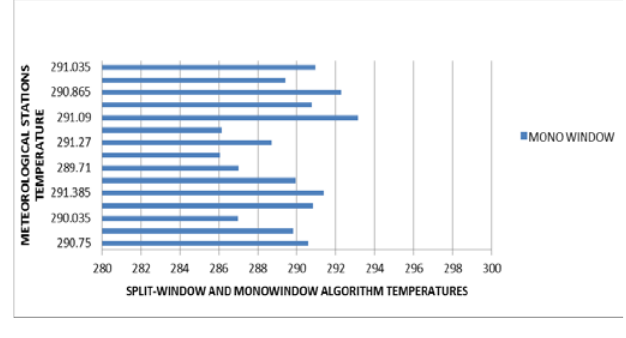
Figure 6. Relation between Meteorogical Stations Temperature and Mono-window Algorithm LST Temperatures.